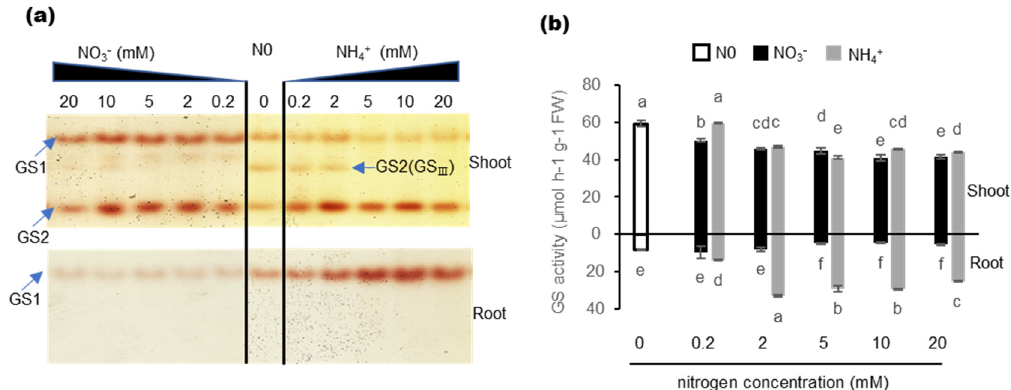
Figure 3. Glutamine synthetase (GS) activity in response to di ff erent nitrogen regimes in shoot and root tissue. ( a ) Native electrophoresis and in-gel GS activity staining showing the GS holoenzymes in shoot and root; ( b ) total GS activity in shoot and root tissue under di ff erent N regimes. Data are means of three independent biological replicates ± SD. Letters above samples indicate statistically significant differences where p < 0.05 according to one-way ANOVA Duncan post-hoc test.